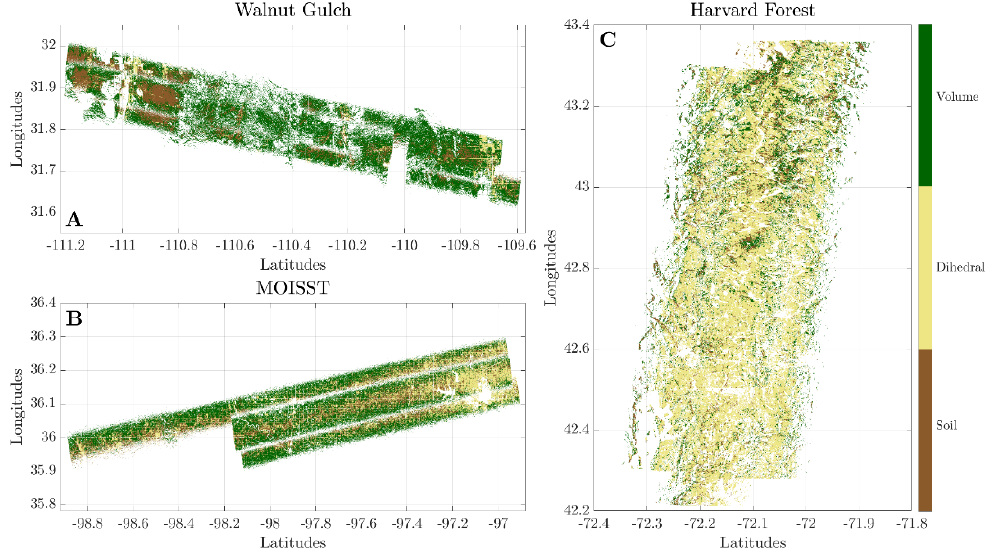
), dihedral 𝑃𝑃 𝑠𝑠 / 𝑃𝑃 𝑑𝑑